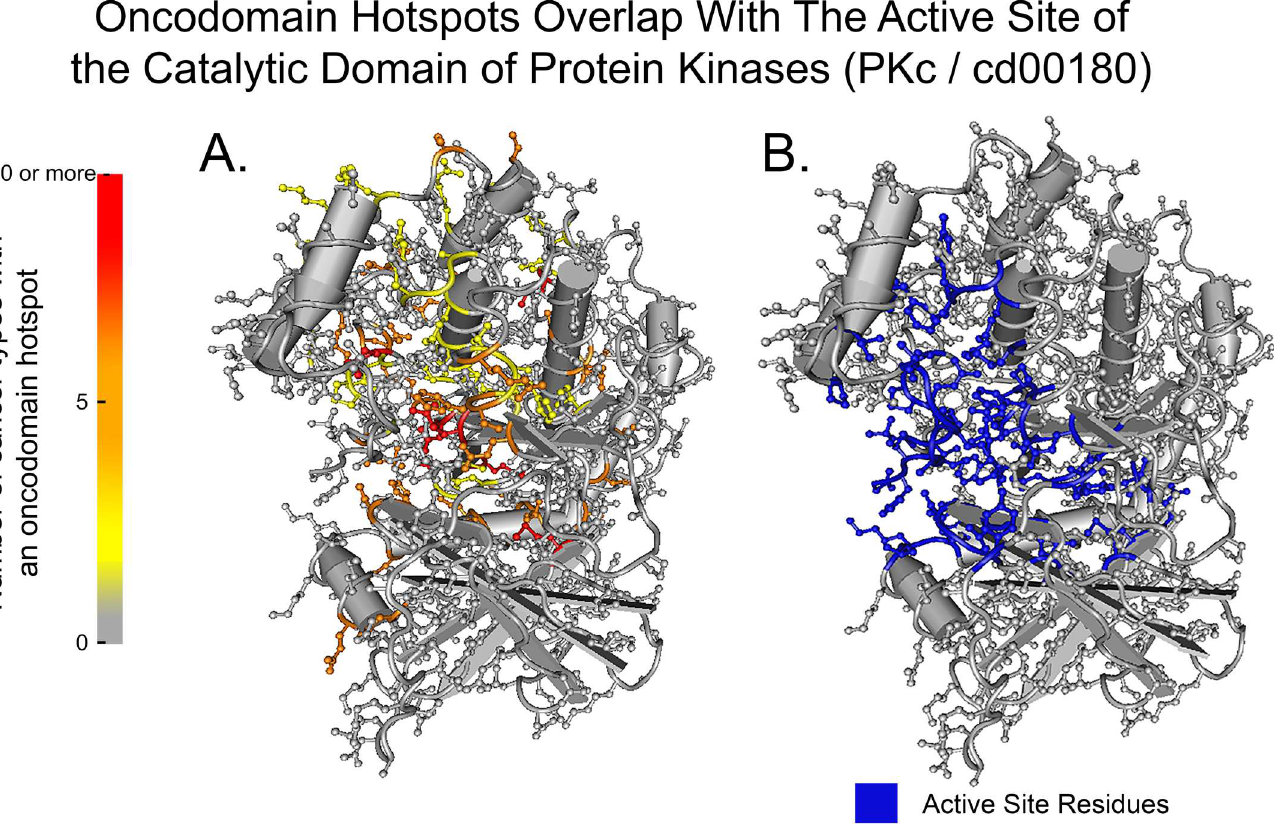
Fig 3. Overlap of oncodomain hotspots with the active site of the catalytic domain of protein kinases. Structural representation of the frequency of oncodomain hotspots across 20 cancer types (A) comparedto the active site residues (B) for the PKc /